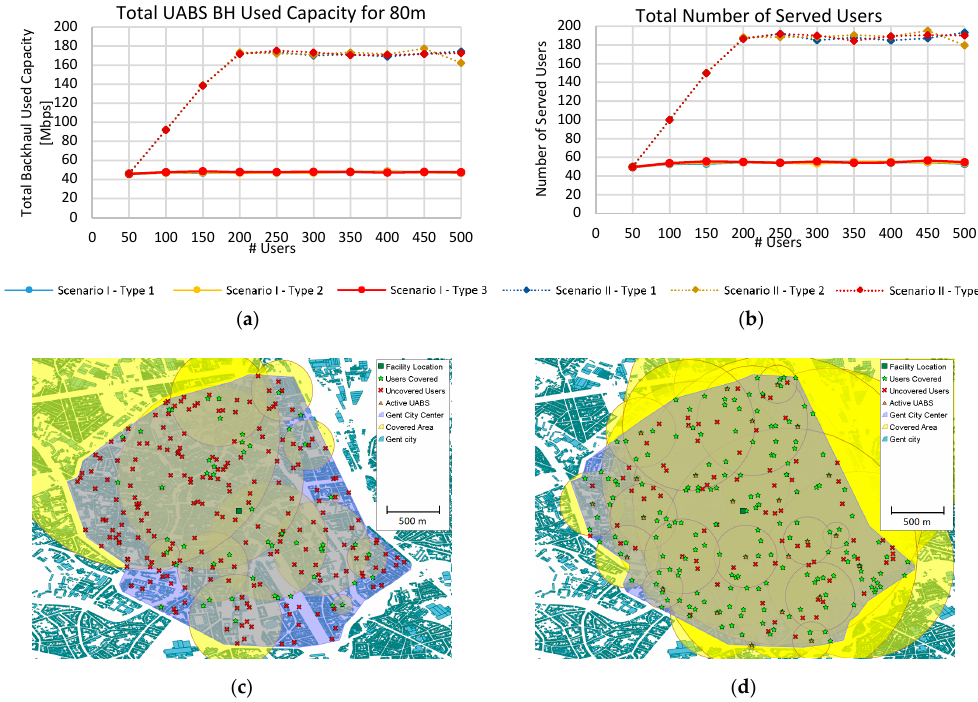
Figure 5. Evaluation results for Scenario II. ( a ) Used capacity of the backhaul for 80 m flight height. ( b ) Provisioned users. ( c ) Network coverage for 260 users at 80 m flight height Type 2 drone in Scenario I. ( d ) Network coverage for 260 users at 80 m flight height Type 2 drone in Scenario II (carrier aggregation). Facility location (dark green square); users covered (green star); uncovered Uuers (red cross); active UABS (orange triangle); covered area (yellow circle).